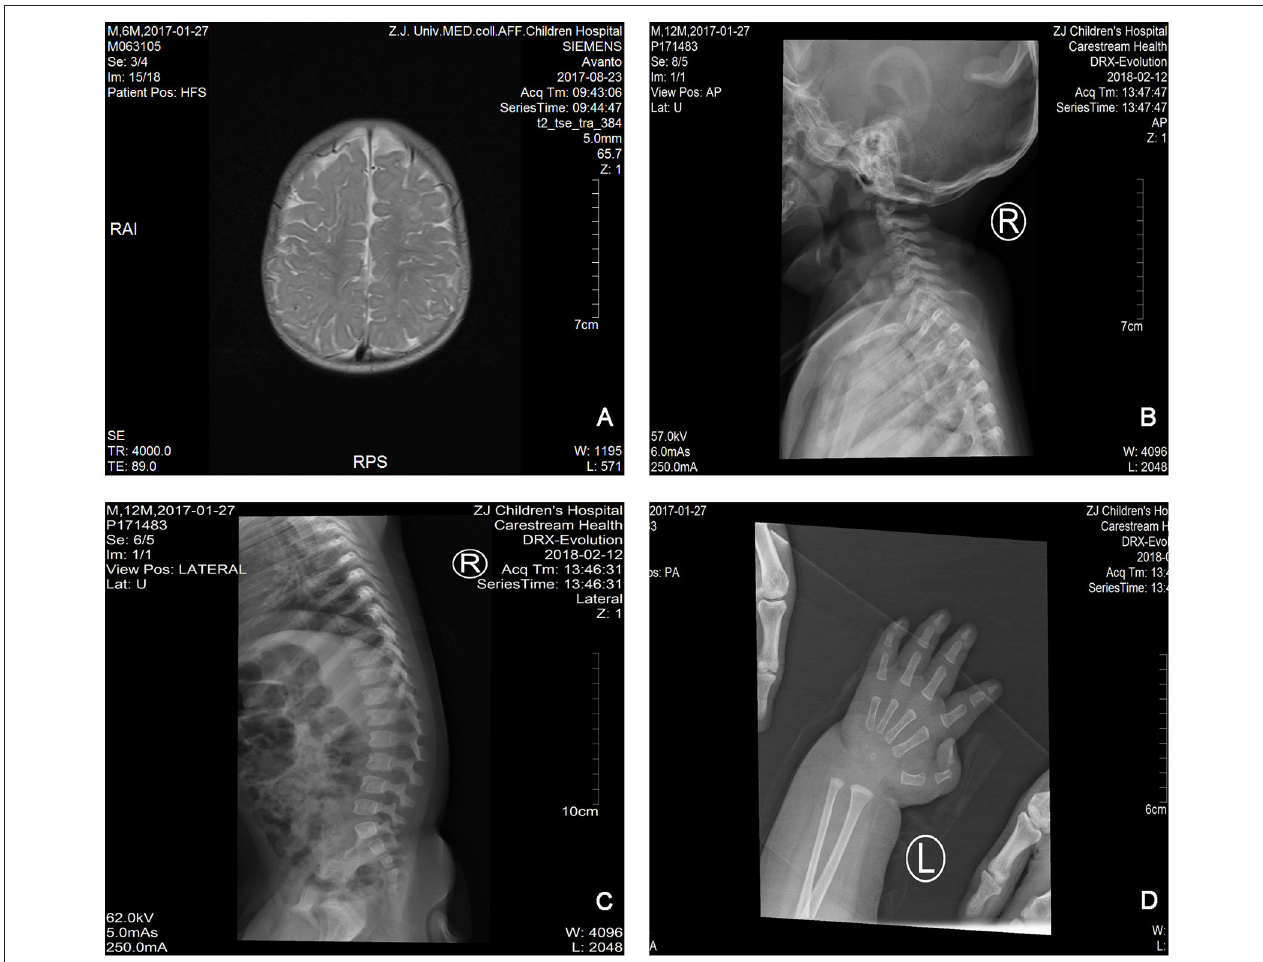
FIGURE 2 | The magnetic resonance imaging (MRI) and X-ray images of the Coffin–Lowry syndrome case. (A) The MRI of cerebral development; (B,C) Cervical and spinal canal X-ray photographs. (D) Nodular hyperplasia of finger tail